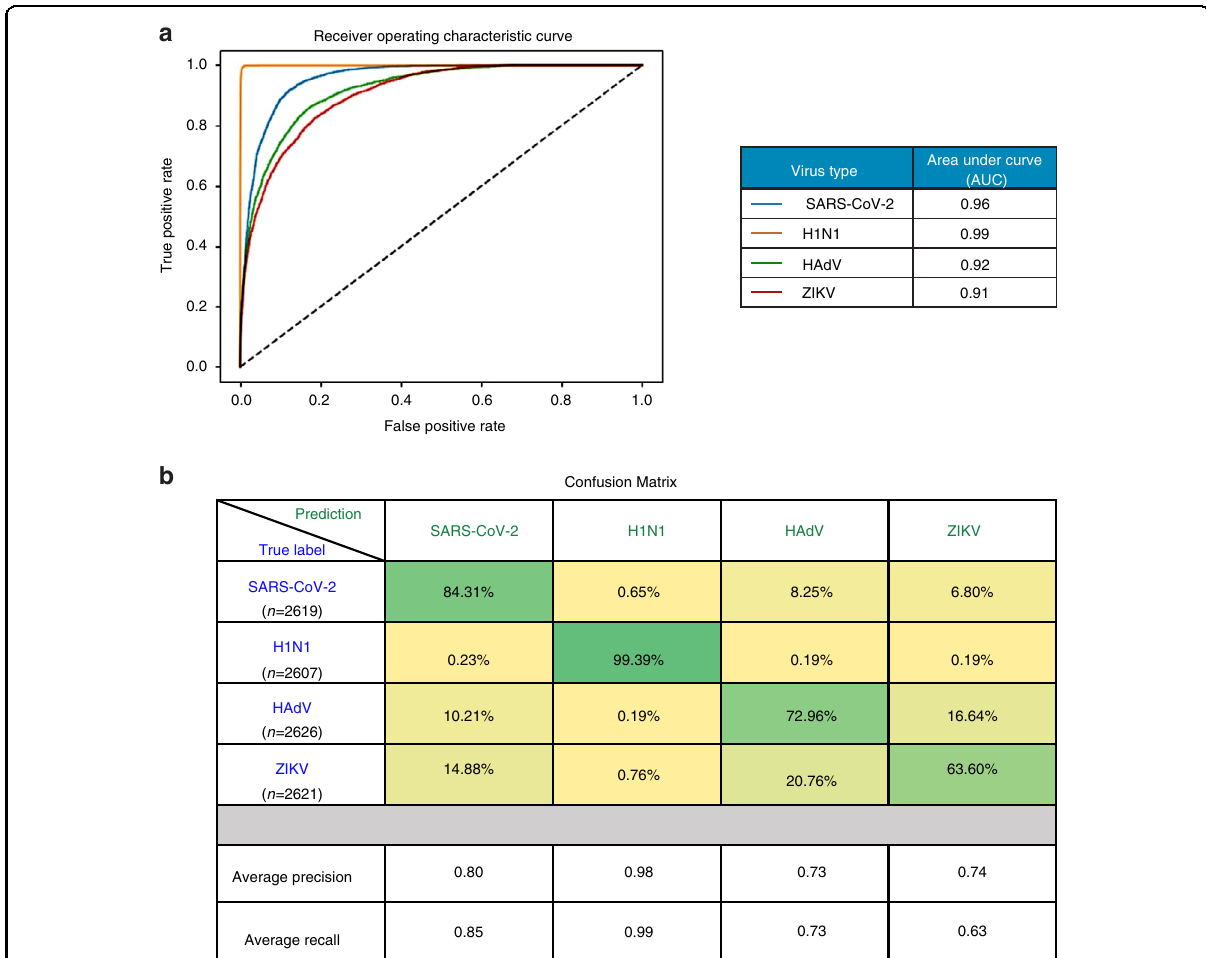
Fig. 6 Model performance on the test dataset. a The receiver-operating characteristic (ROC) curve of the model on the test dataset. The model achieved over 0.9 area-under-curve (AUC) for all four virus types on the test dataset. The area-under-curve (AUC) for each class is computed by setting that class as label 1 and all other classes (the three remaining virus types) as label 0. b The confusion matrix of the model inference on the test dataset. Each row represents the ground-truth label, while each column represents the prediction. For visualization purposes, each entry in the confusion matrix was normalized with respect to the number of true labels (sum of each row). The precision and recall are averaged across all images in the test dataset. Both the ROC curve and the confusion matrix are evaluated on a per-particle level, where weighted average is computed to resolve con fl ict in model raw